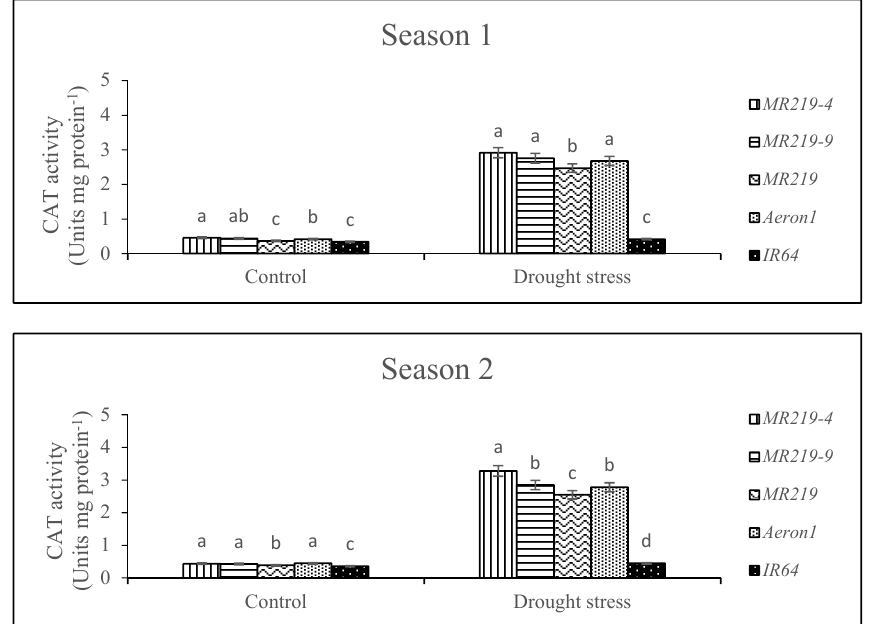
Figure 3. Effect of drought stress treatment on CAT activities in rice genotypes. Vertical bars represent ± standard error. Values within drought stress treatment with the different letter are significantly different based on comparison using DNMRT at p ≤ 0.01 ( n = 20).